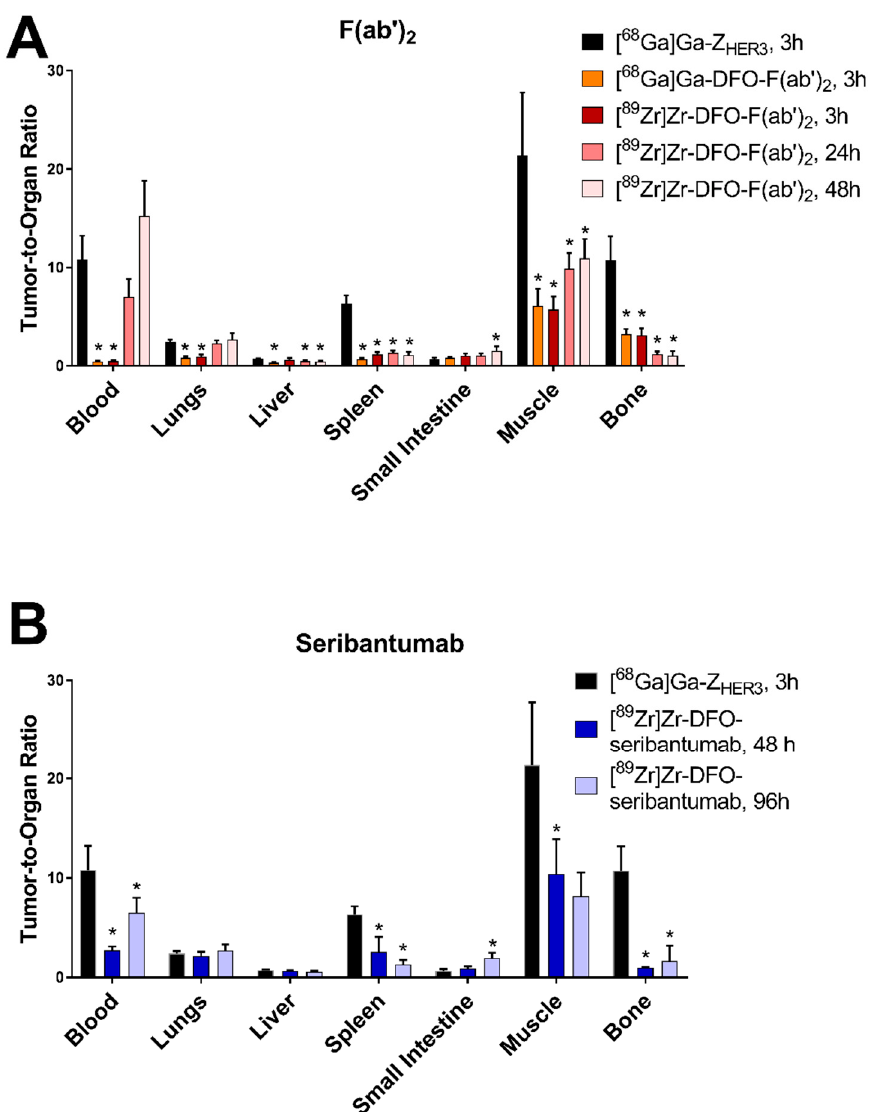
Figure 5. Tumor-to-organ ratios of ( A ) [ 68 Ga]Ga-DFO-seribantumab-F(ab’) 2 , [ 89 Zr]Zr-DFO-seribantumab-F(ab’) 2 , and ( B ) [ 89 Zr]Zr-DFO-seribantumab in balb/c nu/nu mice with HER3-expressing BxPC-3 xenografts. Tumor-to-organ ratios of [ 68 Ga]Ga-Z HER3 3 h pi were added to the respective graphs for comparison. Data are presented as the average of n = 4–6 animals with SD. * Indicates a statistically significant difference ( p < 0.05) with [ 68 Ga]Ga-Z HER3 . Numerical data as well as detailed information on statistically significant differences between groups can be found in Supplementary Material- Tables S1 and S2.